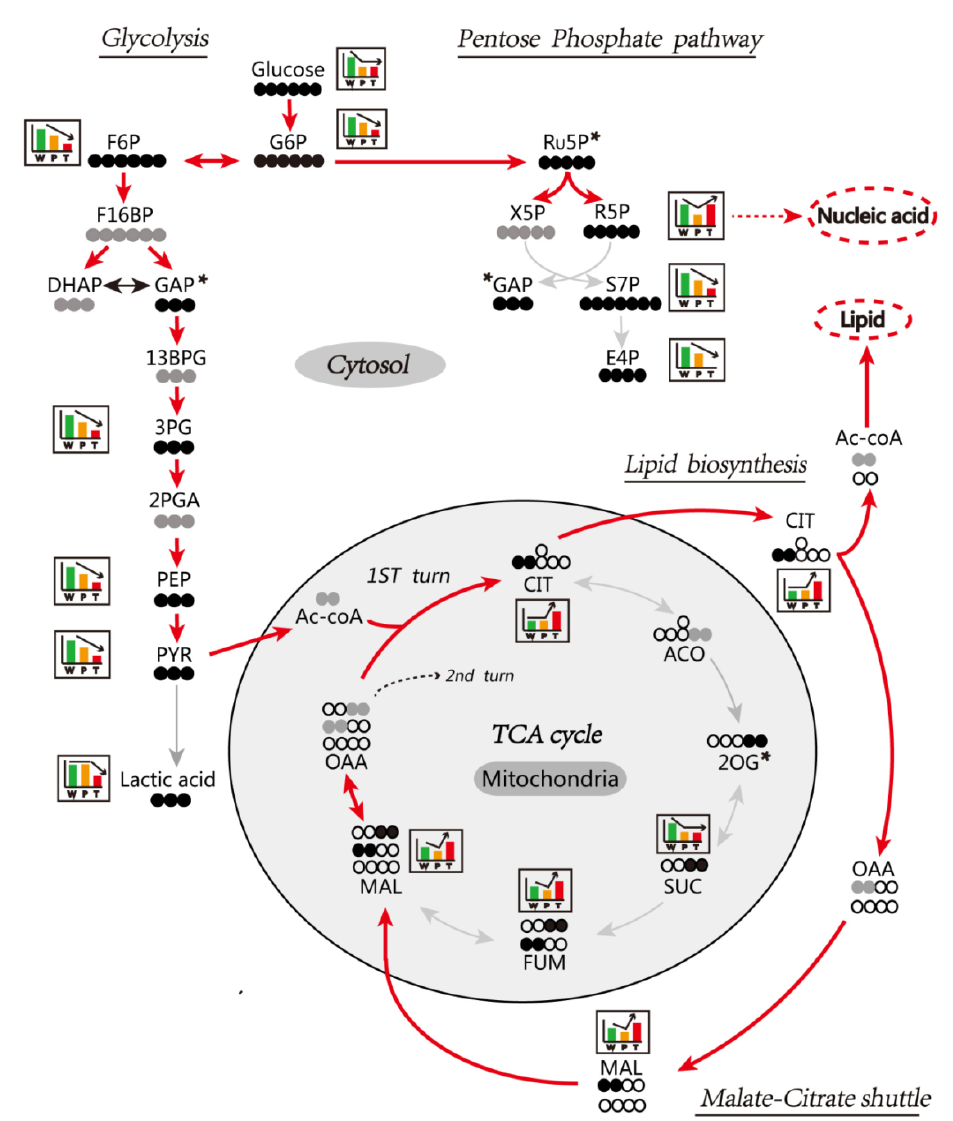
Figure 5. Schematic representation of [U- 13 C] glucose metabolic flux in the liver. The metabolic flux of [U- 13 C] glucose in the glycolysis, the pentose phosphate pathway, and the tricarboxylic acid (TCA) cycle is demonstrated. The solid and hollow black circles represent the 13 C and 12 C, respectively. The solid gray circles represent the 13 C in undetected metabolites. The boxes with histograms represent the expression-patterns among W, P, and T (significant changes at least twice in pairwise comparison). The asterisks represent metabolites with no change or only a single significant change in a pairwise comparison. The histogram bar represents the relative expression levels of W (green histogram), P (orange histogram), and T (red histogram), and the bar’s height indicates a significant change in expression levels. G6P: glucose 6-phosphate; F6P: fructose 6-phosphate; F16BP: fructose-1,6-bisphosphate; DHAP: dihydroxyacetone phosphate; GAP: glyceraldehyde 3-phosphate; 13BPG: 1,3-bisphosphoglycerate; 3PG: 3-phosphoglycerate; 2PGA: